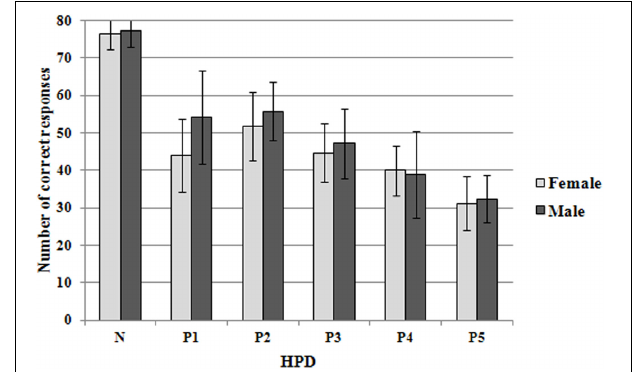
FIGURE 3 | Mean number of correct responses (for one session of 80 sounds) in the localization task for the different test conditions. N: no HPD; P1–P5: for different HPDs. Error bars show ± 1 standard deviation of the mean across listeners in the gender group considered (male or